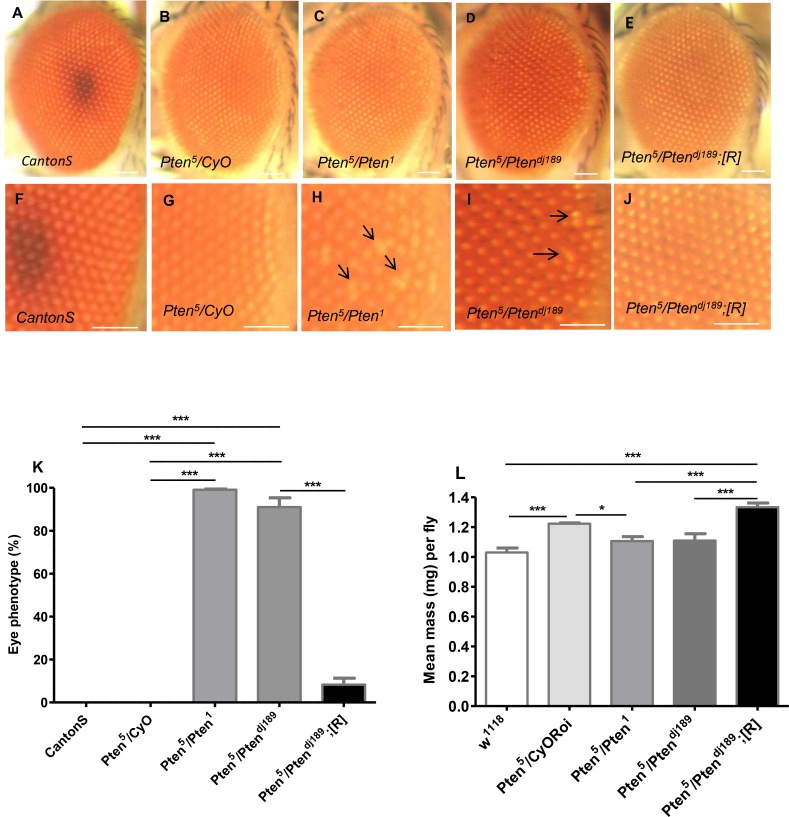
Transheterozygous Pten
5 mutant flies have a highly penetrant eye phenotype.
A-J. Low (A-E) and high (F-J) magnification views of eyes from females of different genotypes. A mild disorganisation of the ommatidia in the posterior region of the eye is observed in Pten
5
/Pten
1 (C,H) and Pten
5
/Pten
dj189 (D, I) flies, as shown by black arrows in H and I, but not in wild type CantonS (A,F) and Pten
5 heterozygous control females (Pten
5
/CyO) (B,G). Almost all female mutant animals carrying a Pten genomic rescue construct (Pten
5
/Pten
dj189
;[R]) (E,J) do not display the eye phenotype. (K) Histogram presented as mean percentage of flies exhibiting disorganised eye phenotype. Error bars indicate standard error of mean (SEM). *** P < 0.001, from two separate experiments n ≥ 100. (L) The mean body mass of different Pten mutant females, Pten
5
/Pten
1 and Pten
5
/Pten
dj189, is not significantly heavier than wild type w
1118. Surprisingly, Pten
5
/Pten
dj189 rescue females have significantly higher body mass than all other genotypes. Data are presented as mean body mass per fly ± SEM. Pooled from two independent experiments, n ≥60. Statistical significance was determined by two-tailed unpaired Student’s t-test. Scale bar: 100μm.